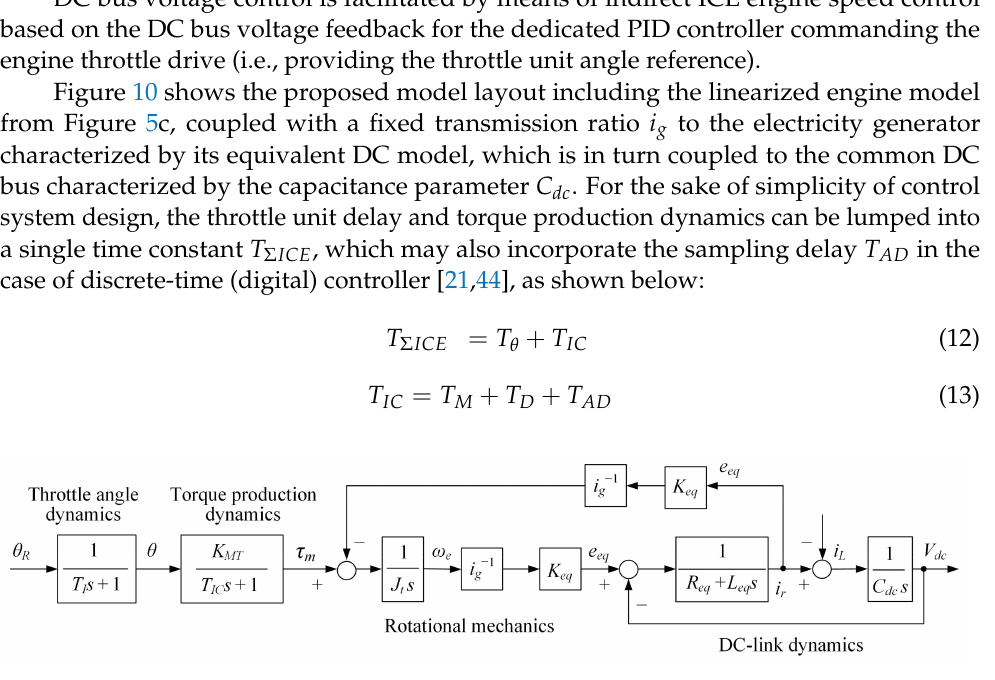
Figure 10. DC bus voltage control system process